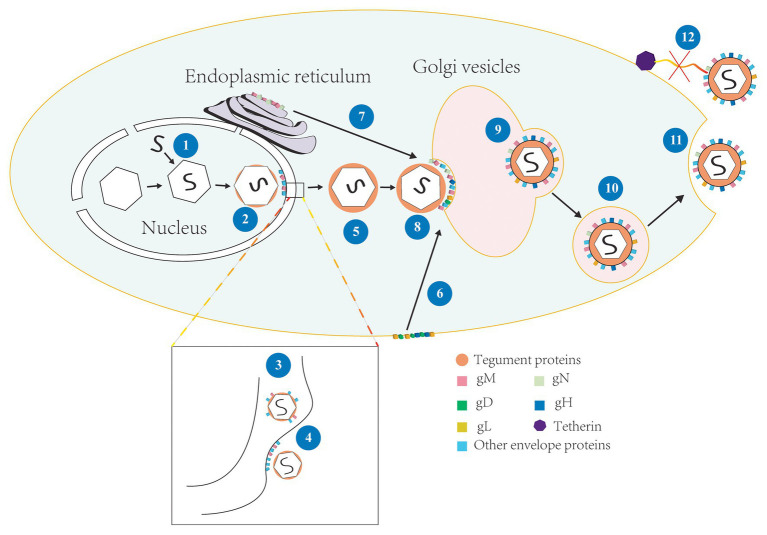
The involvement of gM in the life cycle of HSV-1. (1) Viral genome is assembled into the capsid to form the nucleocapsid (Skepper et al., 2001); (2) The nucleocapsid acquires a small number of tegument proteins in the nucleus (Baines et al., 2007; Wills et al., 2009); (3) Immature virions budding in the inner nuclear membrane and enter the perinuclear space, meanwhile, gM is assembled into the primary envelope (Baines et al., 2007; Zhang et al., 2009); (4) The primary envelope is de-envelopment at the outer membrane and the naked nucleocapsid is released into the cytoplasm; (5) The naked nucleocapsid acquires a large number of tegument proteins in the cytoplasm (Johnson and Baines, 2011; Maringer et al., 2012); (6) gD, gH, and gL located on the surface of cell membrane were internalized by gM and relocated to Golgi apparatus (Ren et al., 2012); (7) gN and gM located in the endoplasmic reticulum (ER) form complex and matures, and then transfer to Golgi apparatus (Graul et al., 2019); (8) The nucleocapsid is wrapped by tegument proteins and obtained the ultimate envelope at the Golgi apparatus (Turcotte et al., 2005); (9)–(10) The vesicles derive from Golgi apparatus and wrap the enveloped virions and transported them to the cell membrane (Sugimoto et al., 2008); (11) Progeny virions released by exocytosis at cell membrane (Turcotte et al., 2005; Johnson and Baines, 2011); and (12) gM antagonized the tetherin and virions were successfully released (Blasius et al., 2006).